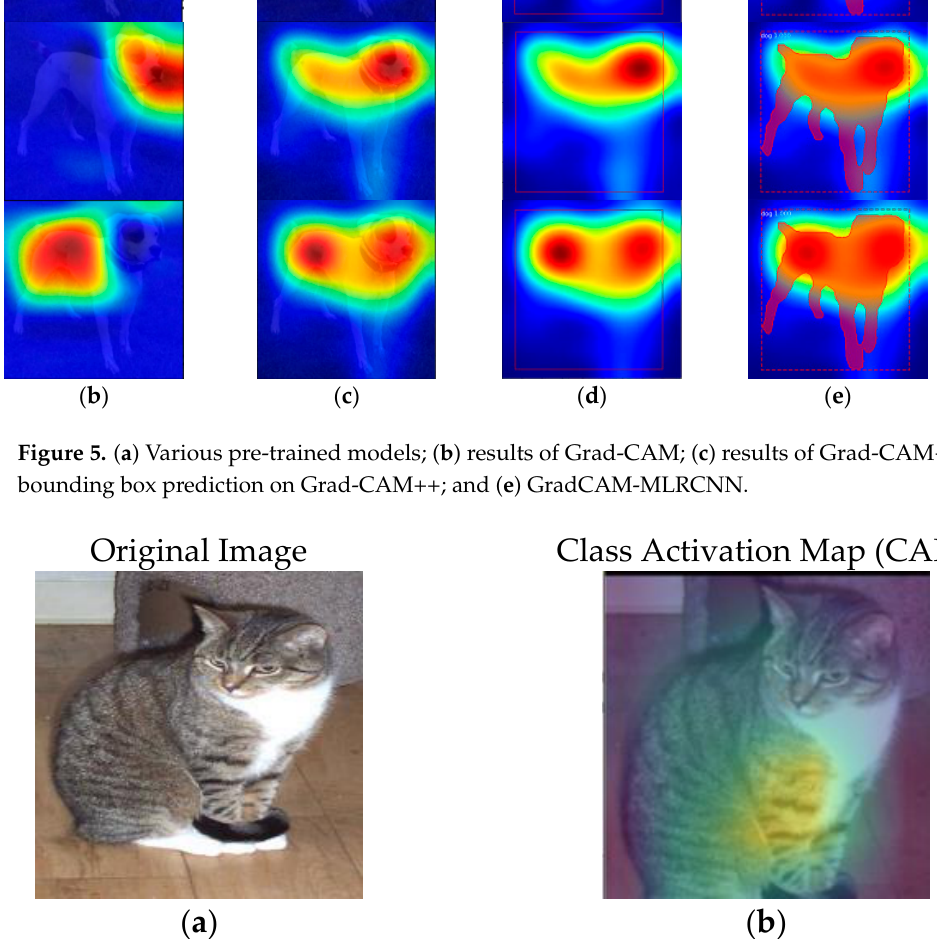
Figure 6. ( a ) Input image; ( b ) output of class activation map (CAM). Figure 7 demonstrates the results of various pre-trained models, such as VGG 16, VGG 19, ResNet 101, and ResNet 152 with the corresponding results of Grad-CAM, Grad-CAM++, bounding box prediction, and proposed method (GradCAM-MLRCNN), which contains the bounding box with mask prediction with respect to k -nearest neighbor : (a) various pre-trained models; (b) results of Grad-CAM; (c) results of Grad-CAM++; ( d ) bounding box prediction on Grad-CAM++; and (e) GradCAM-MLRCNN. Figure 8 shows the original image and its corresponding class activation map (CAM).